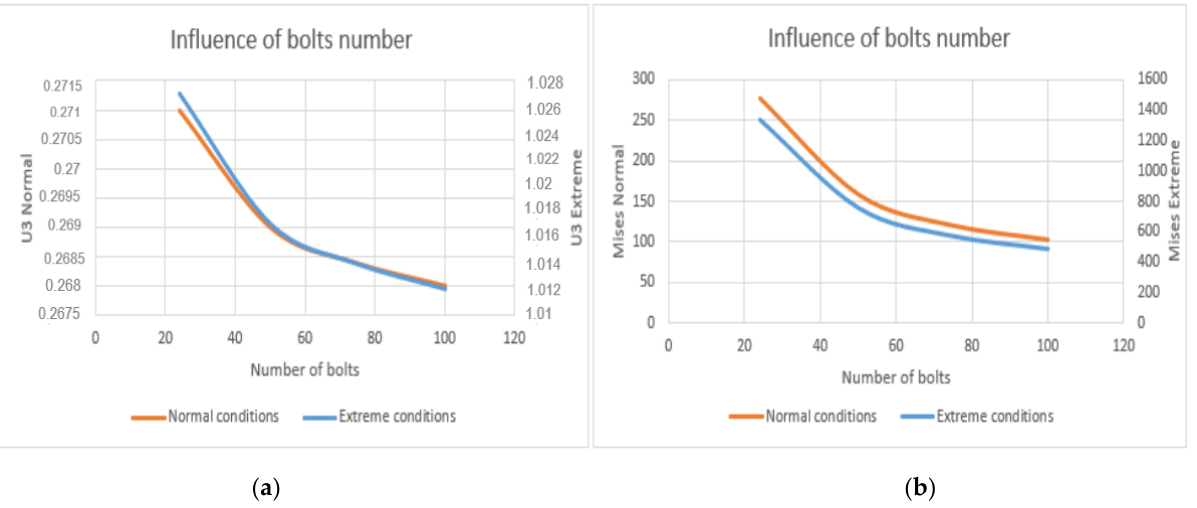
Figure 22. Influence of number of bolts: ( a ) Lateral displacement, ( b ) Von Mises stresses.